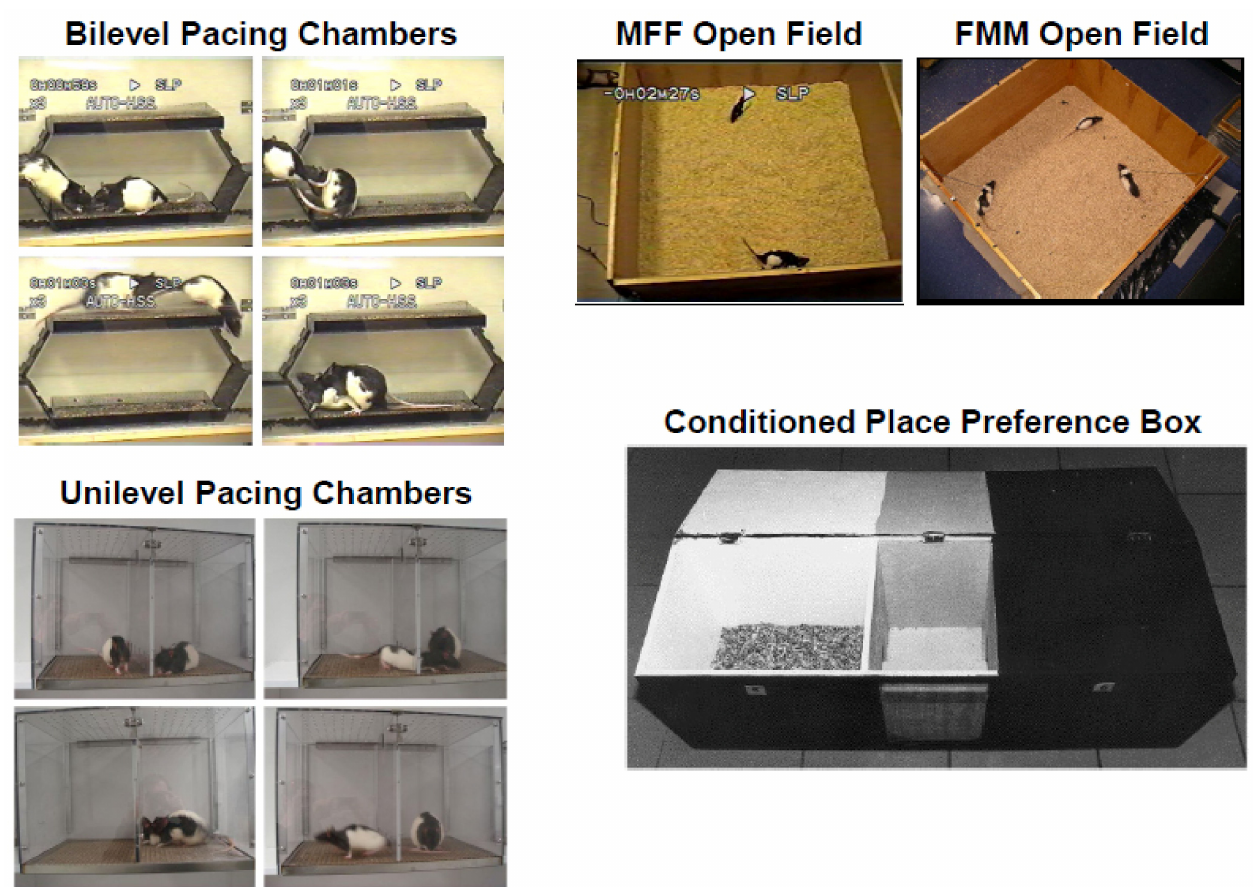
Figure 3. Left : Bilevel and unilevel pacing chambers used for conditioning of partner preferences (adapted from Pfaus et al., [53] with permission. 2015, Elsevier). Pacing chambers allow the female to regulate copulatory contact with the male by either running from level to level ( top ) or by darting through small holes in a divider that are big enough to allow the female to pass through, but too small to allow the male to pass through ( bottom ). In the bilevel pacing chambers, females make a head-wise orientation to the male ( upper left panel ), then hop over him exposing their anogenital area ( top right panel ). Females then run away, forcing the male to chase them ( bottom left panel ), after which they run to the original level and assume a lordosis crouch, allowing the male to mount with intromission ( bottom right panel ). Similarly, in unilevel pacing chambers females can pass through the hole into the male’s side ( top left and right panels ) and solicit an intromission ( bottom left panel ), then exit the male’s side ( bottom right panel ). Each of these sequences depict the initiation and termination of a copulatory bout by the female. Right top : Open fields used for testing conditioned partner preferences and CEP (adapted from Pfaus et al., [53] with permission. 2015, Elsevier). To test CEP, a male is placed into the open field with two females, one scented or jacketed and the other unscented or unjacketed. The male can then copulate freely with either one. To test partner preferences in females, a female is placed with two tethered males, one scented or jacketed, and the other unscented or unjacketed. Males are tethered to avoid their tendency to huddle together. Females compete, so they can remain untethered. Right bottom : Apparatus used to condition and test place preferences after sexual reward training (Reprinted with permission from Paredes and Vasques [54]. 1999. Elsevier). After a requisite amount of copulatory stimulation, a female or male is placed on one side of the box (usually the light side as this is typically not their naturally preferred side). This is contrasted without stimulation, after which the female or male is placed into the naturally preferred (e.g., dark) side. If the copulatory stimulation induces a reward state, then on a final test, after the animal is placed into the middle compartment, it will move to the side with cues that predict the reward state and spend more time there compared to the other